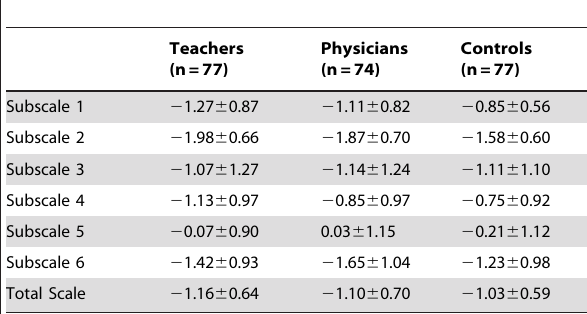
Table 7. Stigma responses of teachers, physicians and control